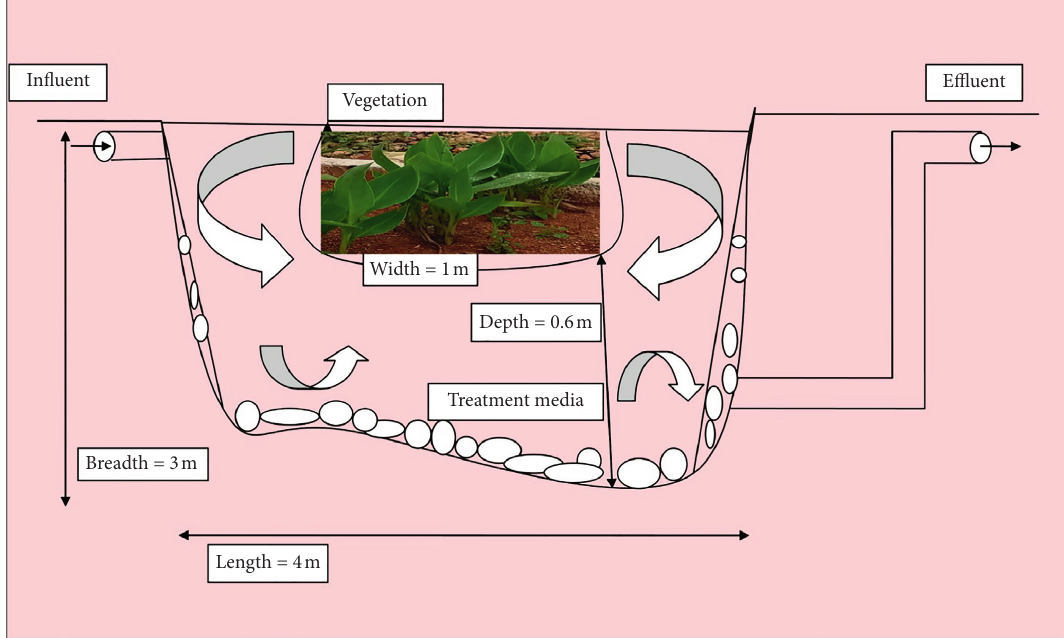
Figure 10: Design of constructed wetland to treat dye effluent.